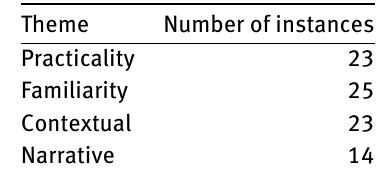
Table 12: Overall References to Themes.